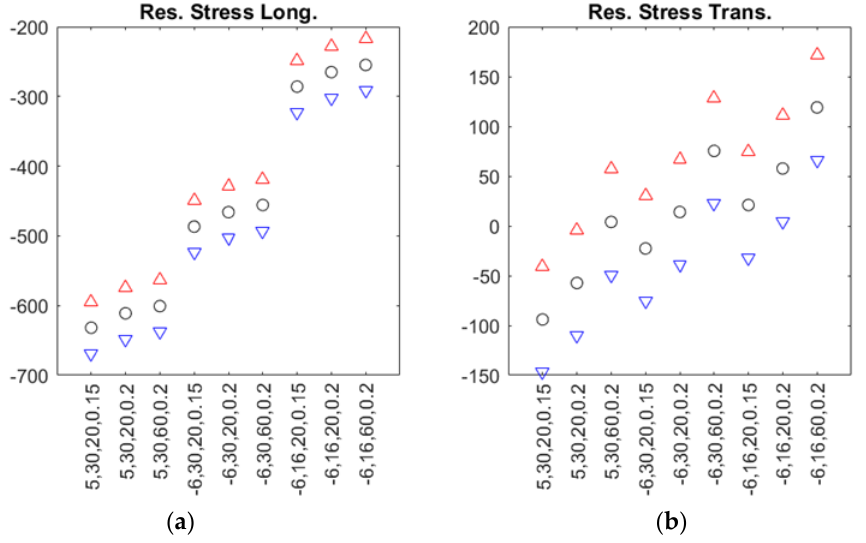
Figure 12. Residual stress predictions for the ( a ) longitudinal and ( b ) directions and corresponding corridor (cutting conditions 2, 4, 8, 9, 10, 11, 12, 15, and 16).